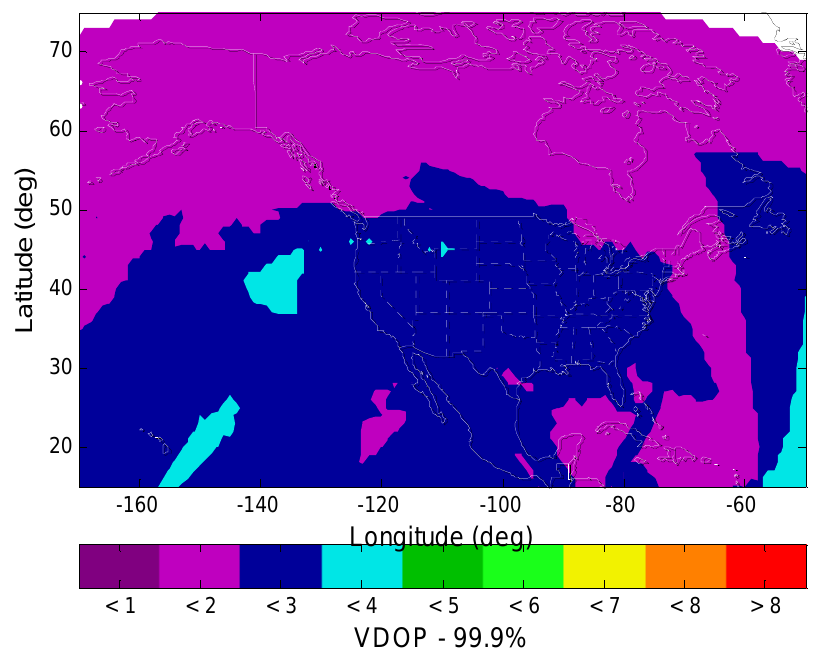
from 1-4 in CONUS, and the VDOP values are from 1-2 in Alaska.